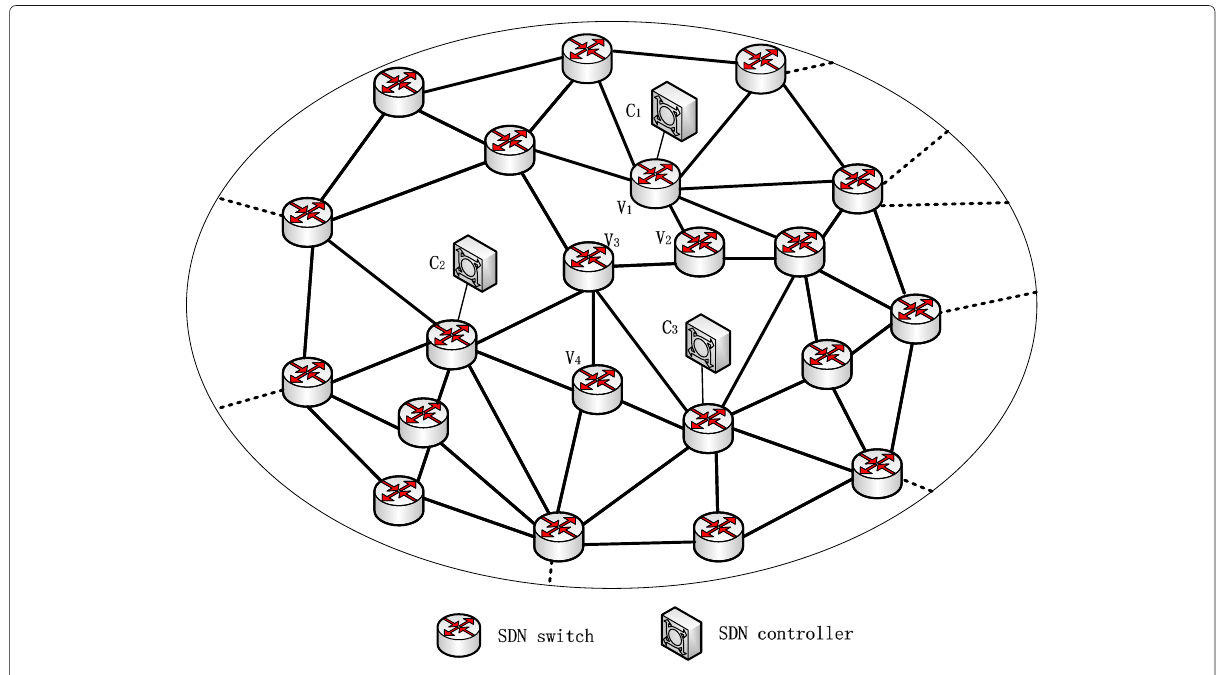
Fig. 1 System model. The system model considered in this paper